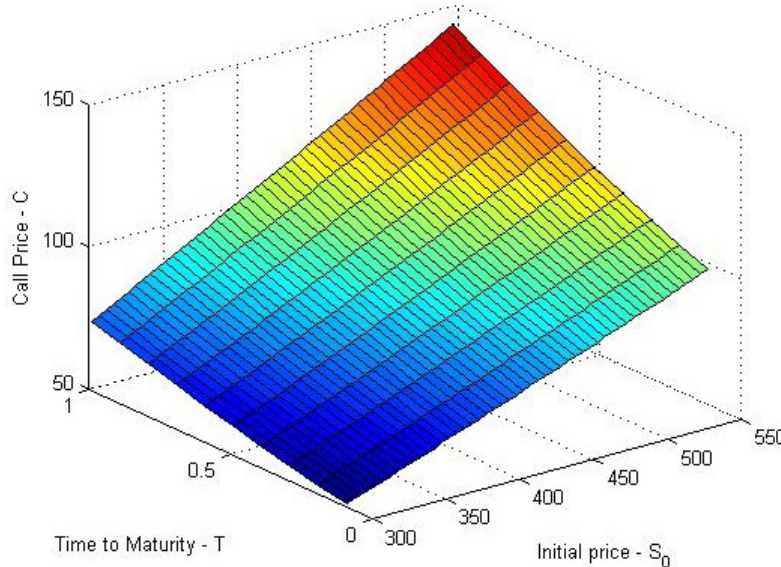
Figure 1. Down-And-Out call with NIG process with Stock Price S 0 = 450, Strike price K = 150, Barrier B = 350, σ = 0.1812, r = 0.167 and Time to maturity T = 1.1.